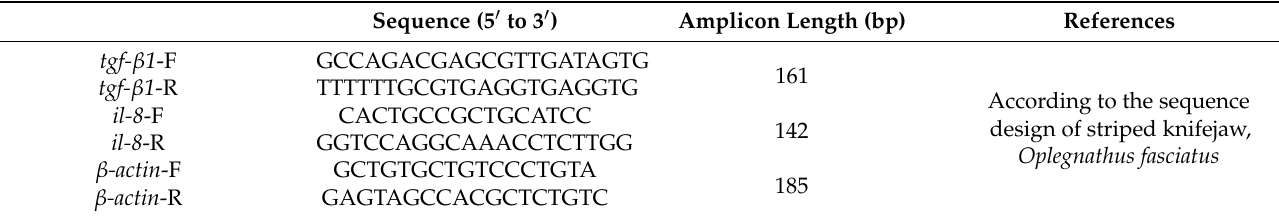
Table 3. The sequences of primers used in this